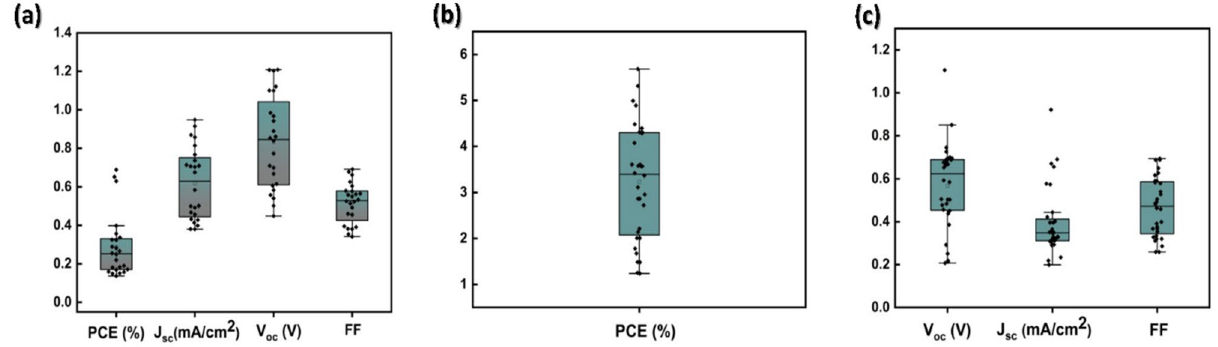
UV (365 nm), and ( c ) Statistic box charts of 0.8 M, 1.5% Cs condition including J sc (mA/cm 2 ), V oc (V), and FF tested under UV (365 nm) irradiation.